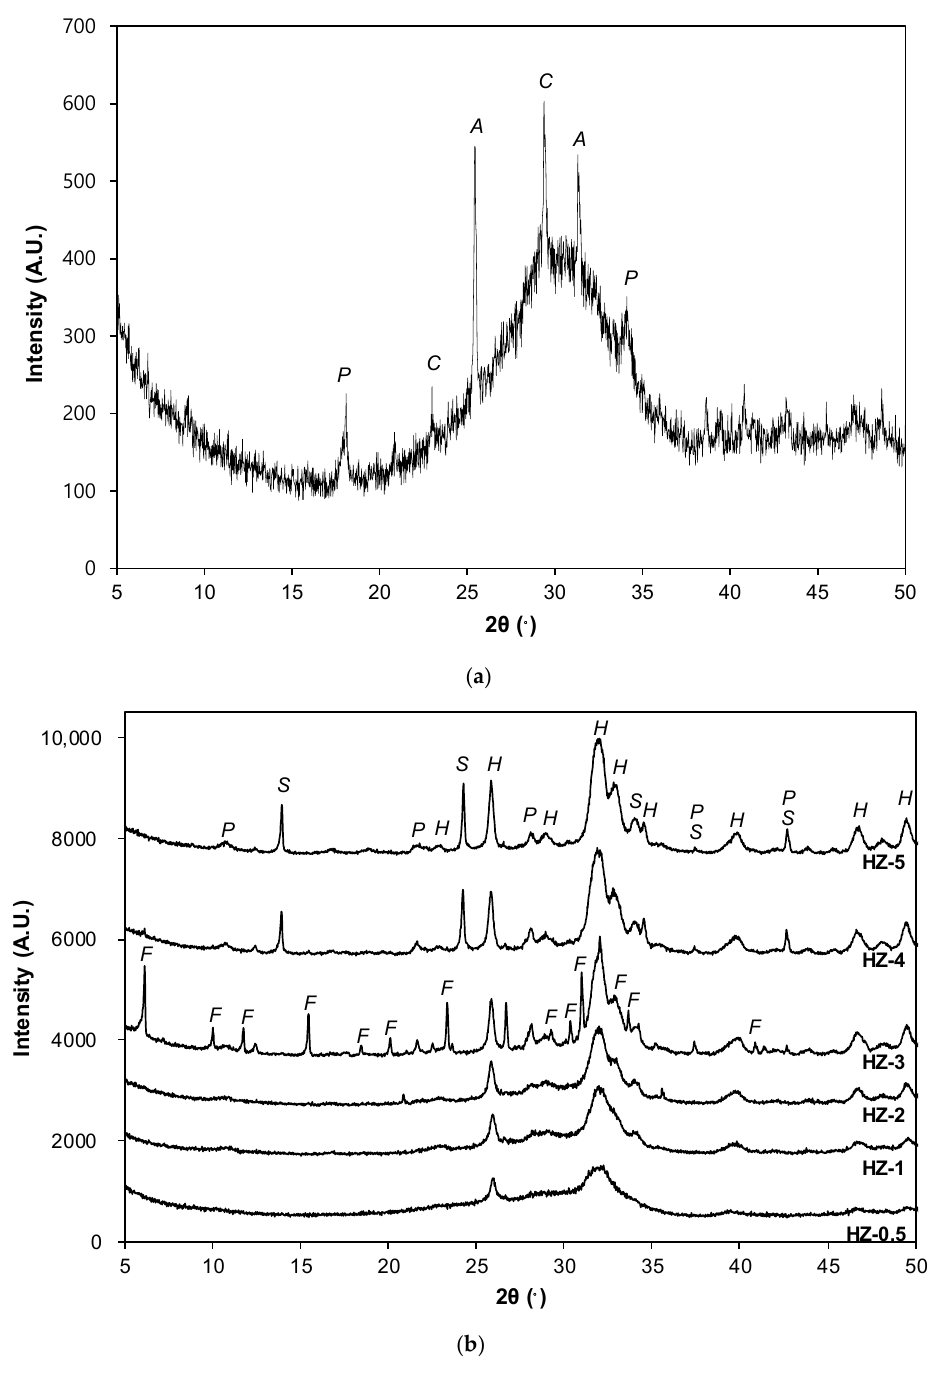
Figure 1. The XRD patterns of the ( a ) raw slag and ( b ) synthesized composite samples (C—calcite; P—portlandite; A—anhydrite; H—hydroxyapatite; F—faujasite (FAU) zeolite; P—Na-P1 zeolite; S—hydroxysodalite).